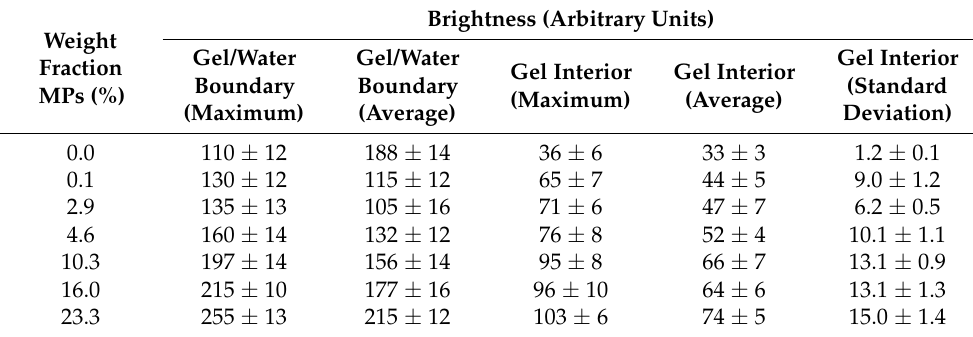
Table 2. Results of the statistical analysis of the ultrasound visualization for ferrogels with PAAm/Guar network filled with different content of iron oxide MPs. The average values with confidence interval at a significance level of p = 0.01 ( n = 60) are